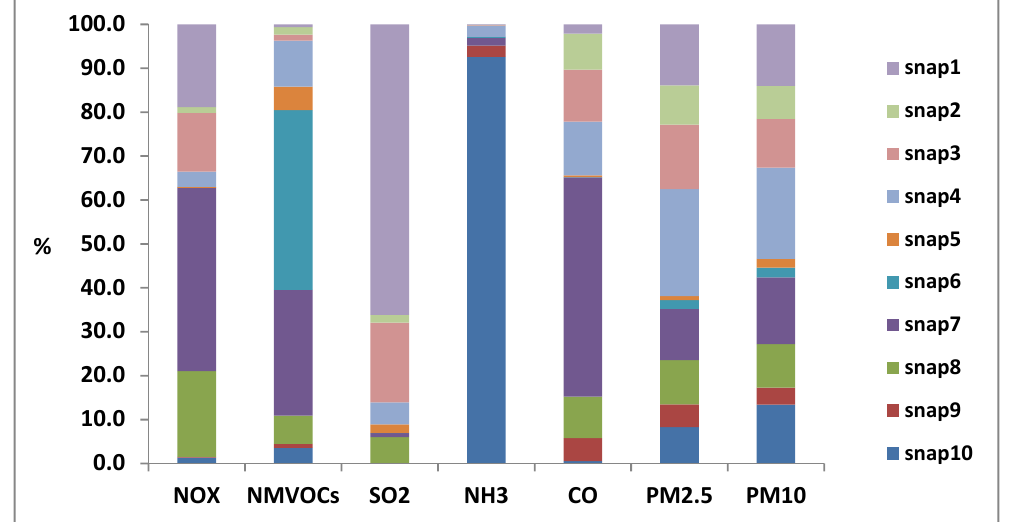
Figure 2. Contribution of each Standard Nomenclature for Air Pollution (SNAP) category to the pollutants emitted over the European land for July